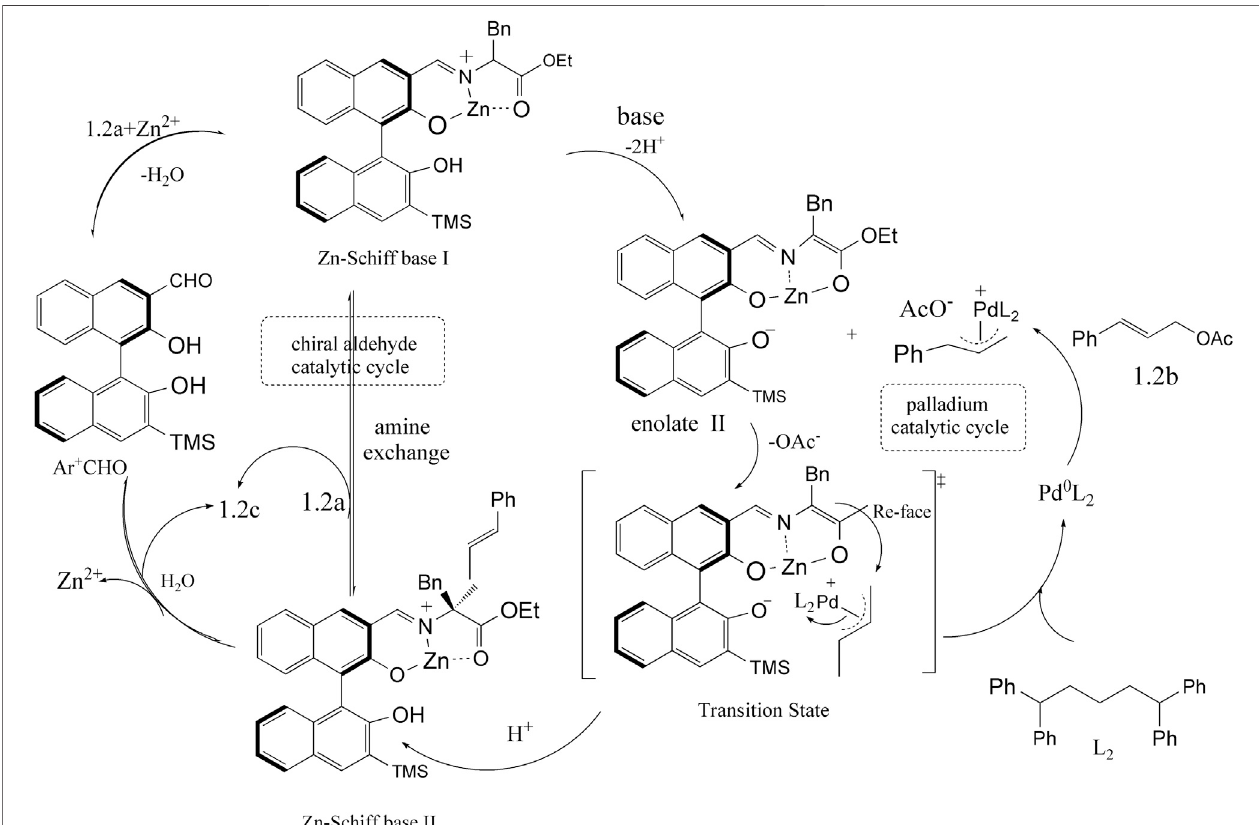
FIGURE 1 | Combining chiral aldehyde catalysis and transition-metal catalysis for enantioselective α -allylic alkylation of amino acid esters (Chen et al., 2019).